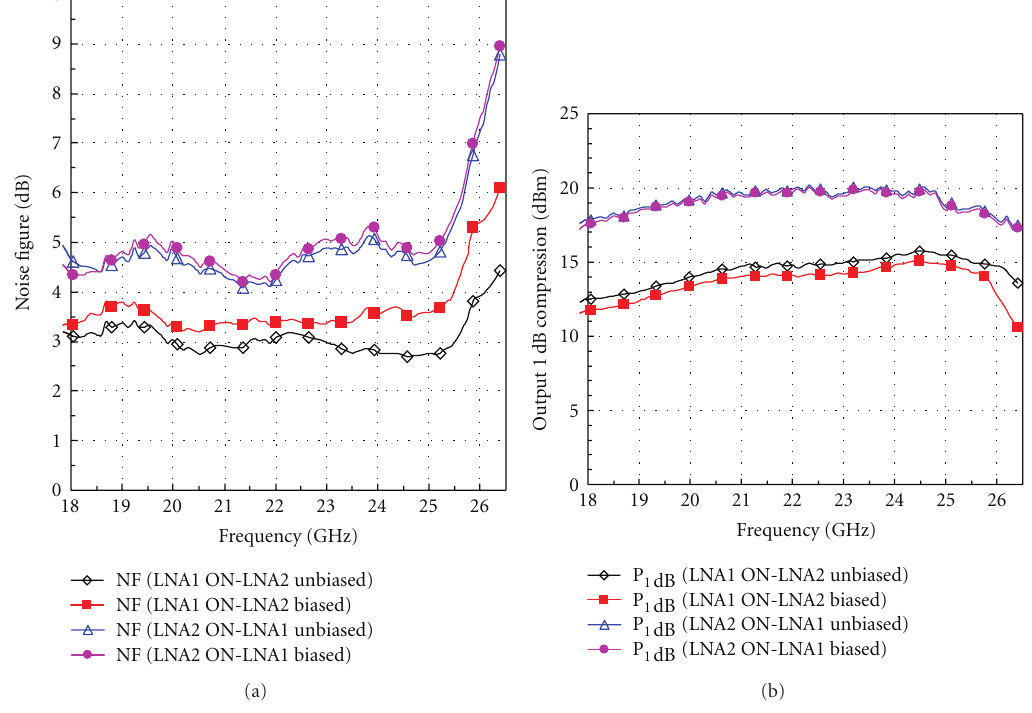
Figure 9: Measured NF (a) and P 1dB (b) of the MEMS reconfigurable LNA (hybrid circuit) for one of the two LNA paths that was switched ON (while the other LNA path was switched OFF and the LNA in that branch was also either unbiased or biased).